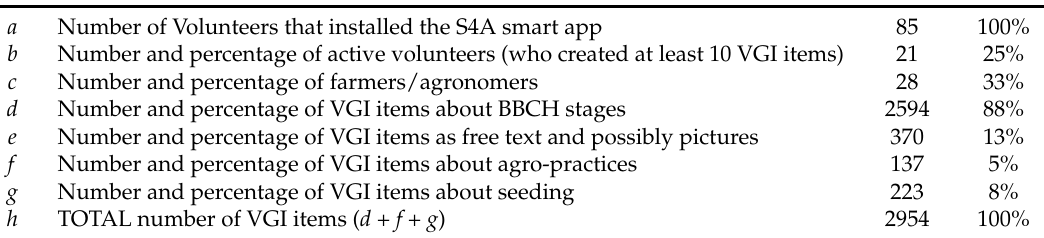
Table 2. Summary of the number of volunteers (by category) and VGI items (by category) created within S4A project during